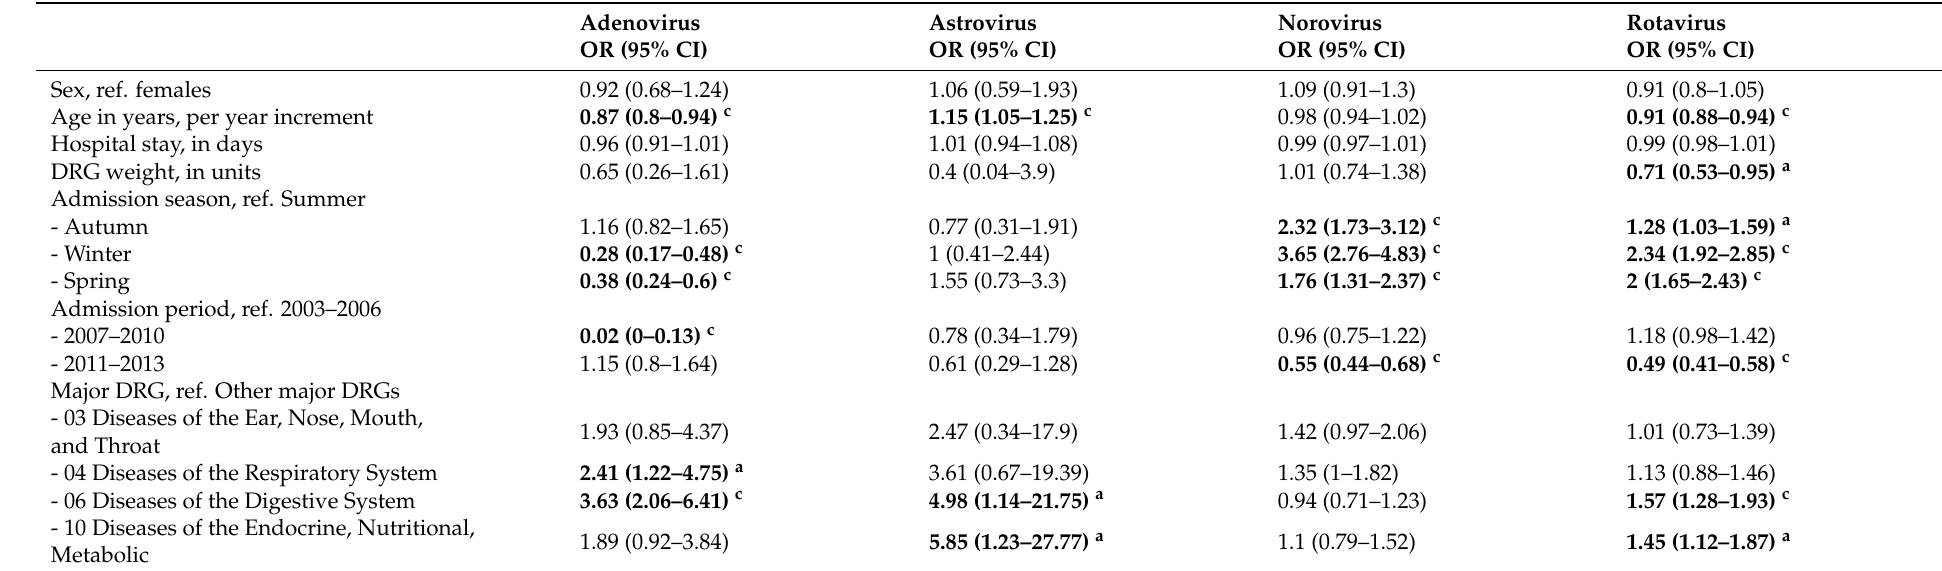
Table 3. Multivariable analysis on risk factors for having an infection with the indicated virus vs. other virus detections/no